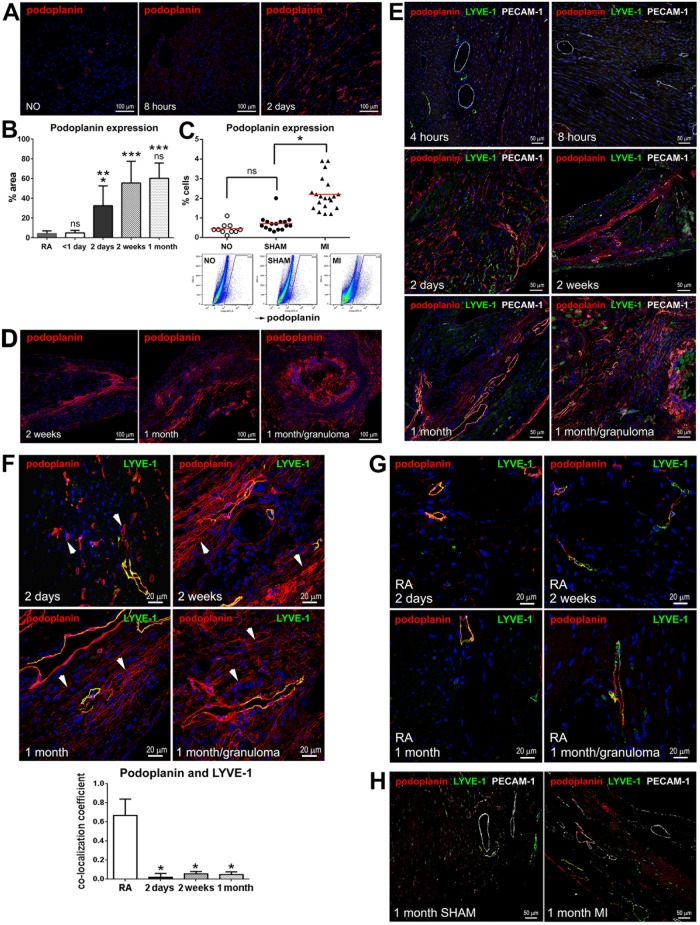
Podoplanin expression in the infarcted and non-infarcted hearts.(A) Thin cardiac sections from non-operated (NO) mice and animals at the indicated times after MI were indirectly immunolabeled with podoplanin (red). Nuclei, blue. Areas neighboring the necrotic myocardium are shown for the infarcted hearts. Note the increase in podoplanin immunoreactivity at 2 days after MI. (B) Quantitative image analysis of the changes in podoplanin immunolabeling in thin cardiac sections in the infarcted myocardium at the indicated times after MI. RA, remote area. Data represent mean and SD of % area stained with podoplanin; n = 6–10 image fields per group. By one-way ANOVA, *P < 0.02 for 2 days vs. RA, 2 weeks, or 1 month; **P = 0.0017 for 2 days vs. < 1 day; ***P < 0.0001 for RA vs. 2 weeks or 1 month and for < 1 day vs. 2 weeks or 1 month; ns, non-significant for < 1 day vs RA, and for 1 month vs. 2 weeks. (C) Flow-cytometry analysis of the frequency of podoplanin-positive cells in the hearts of non-operated (NO), and the sham-operated (SHAM) and infarcted (MI) mice at 2 days after surgery. Graph depicting data from individual animals (upper row) and representative flow-cytometry scatterplots (lower row) are shown. n = 10–20 animals per treatment; mean values are represented by the red line on the graph. By one-way ANOVA, *P < 0.0001 for MI vs. SHAM or NO; ns, not significant for SHAM vs. NO. (D-H) Thin cardiac sections obtained at the indicated times after MI were indirectly immunolabeled with antibodies that recognize podoplanin (D-H; red), LYVE-1 (E-H; green), and PECAM-1 (E and H; grey). Nuclei, blue. Corresponding single channel images (E-H) are included in S1 Fig. Areas affected by ischemia are depicted in D-F; Remote area (RA) is shown in G. SHAM, sham-operated in H. In F, the arrowheads in representative images (upper panels) point to the examples of podoplanin-positive LYVE-1 negative cells. Note the accumulation of LYVE-1-positive CLVs (red and green) as well as podoplanin-expressing cells lacking the LYVE-1 labeling (red only) in the infarcted myocardium as opposed to RA and SHAM. Quantitative image analysis (lower panel) of the podoplanin co-labeling with LYVE-1 is included in the graph. Data represent mean and SD of the co-localization coefficient measured at indicated times after MI and the remote area (RA); n = 5–10 image fields per group. By one-way ANOVA, *P < 0.0001 for RA vs. 2 days, 2 weeks or 1 month; no significant changes between 2 days and 2 weeks and 1 month.